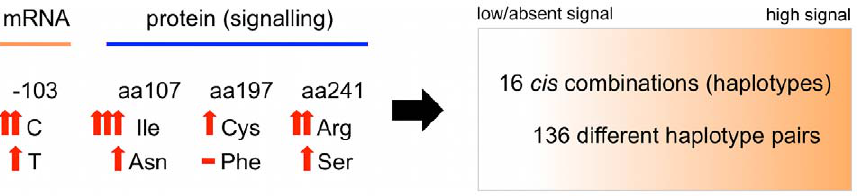
Figure 6. Functional variability in NPSR1 receptor signalling. Based on the results obtained in this study, allelic differences in mRNA expression and protein signalling capacity exist, respectively, at SNPs corresponding to promoter position 2 103 and amino acid residues 107, 197 and 241. This is graphically represented by vertical arrows in the figure, where more arrows indicate higher expression or stronger signalling, respectively, for promoter and coding SNPs. In theory, this results in 16 potential cis combinations of NPSR1 functional alleles into haplotypes, and 136 different pairs of such haplotypes from 2 chromosomes, establishing a very large gradient of NPSR1 functional variation ranging from low/absent to very high signalling.